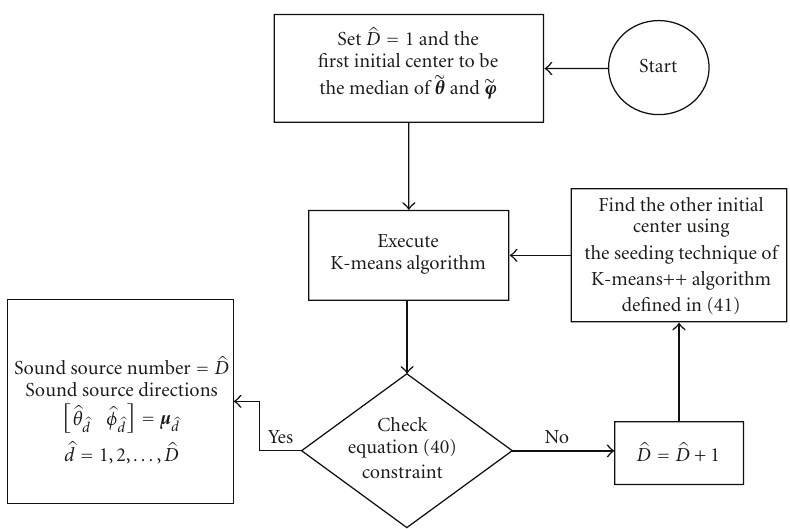
Figure 5: The flowchart of adaptive K-means++ algorithm.